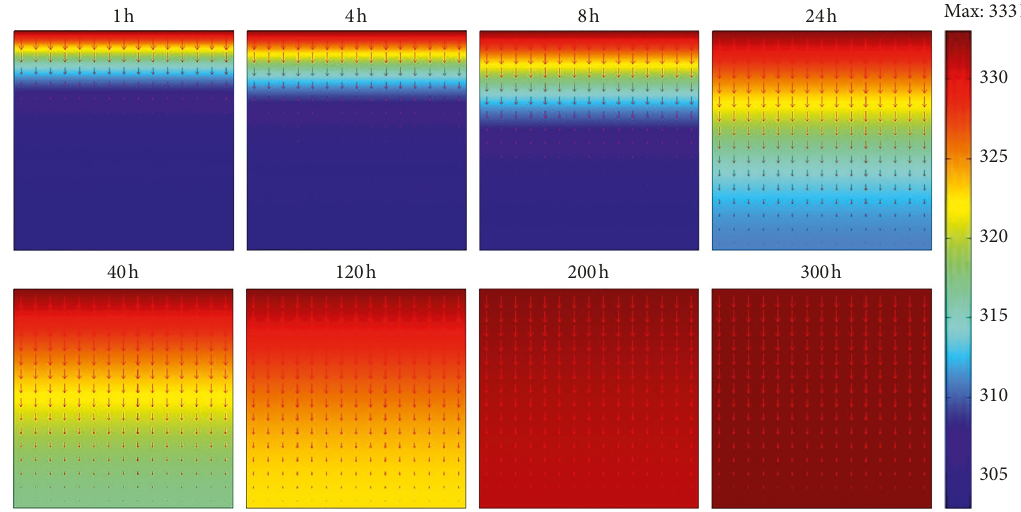
Figure 9: Temperature change law of the model.